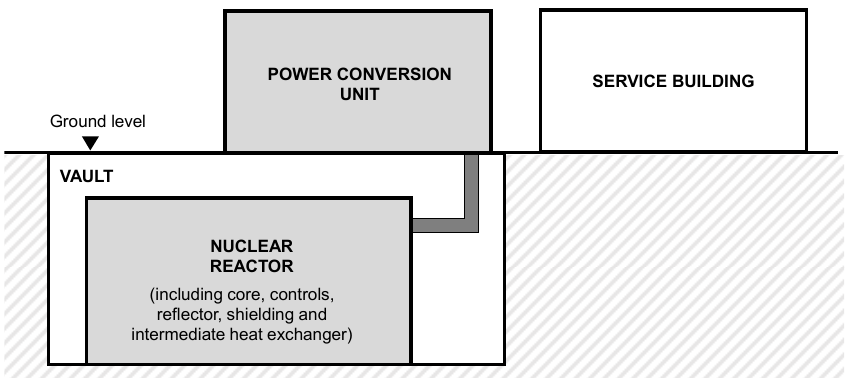
Figure 7. Basic elements of a NB site with below-grade micro-reactor.